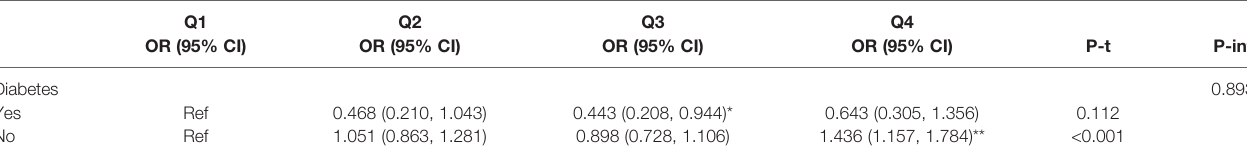
TABLE 5 | Subgroups analysis for the association between METS-IR and